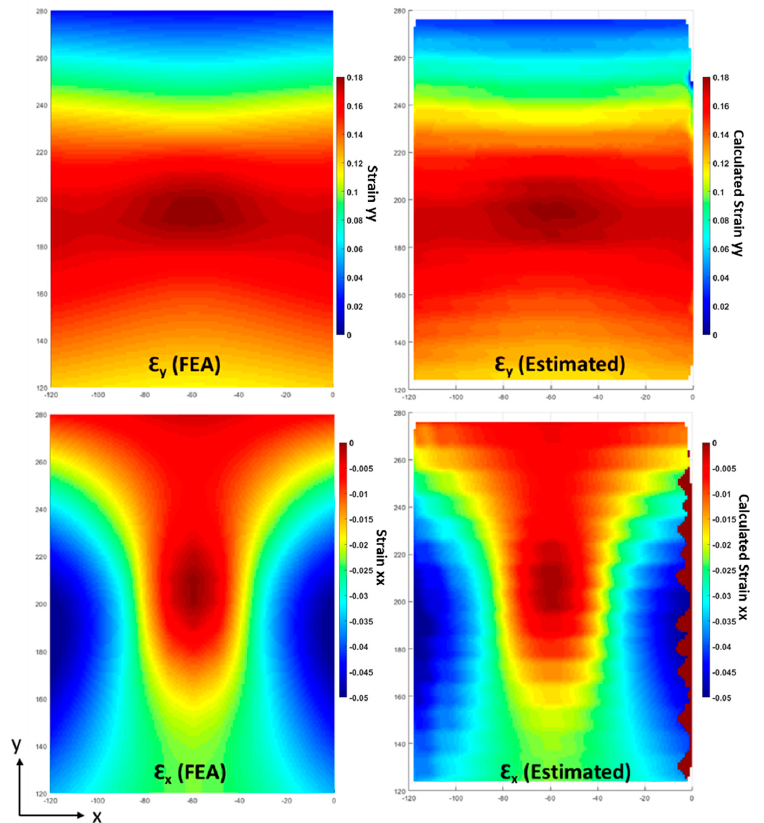
Figure 7. Strain contour plots along x and y for FEA and estimated using the proposed technique.